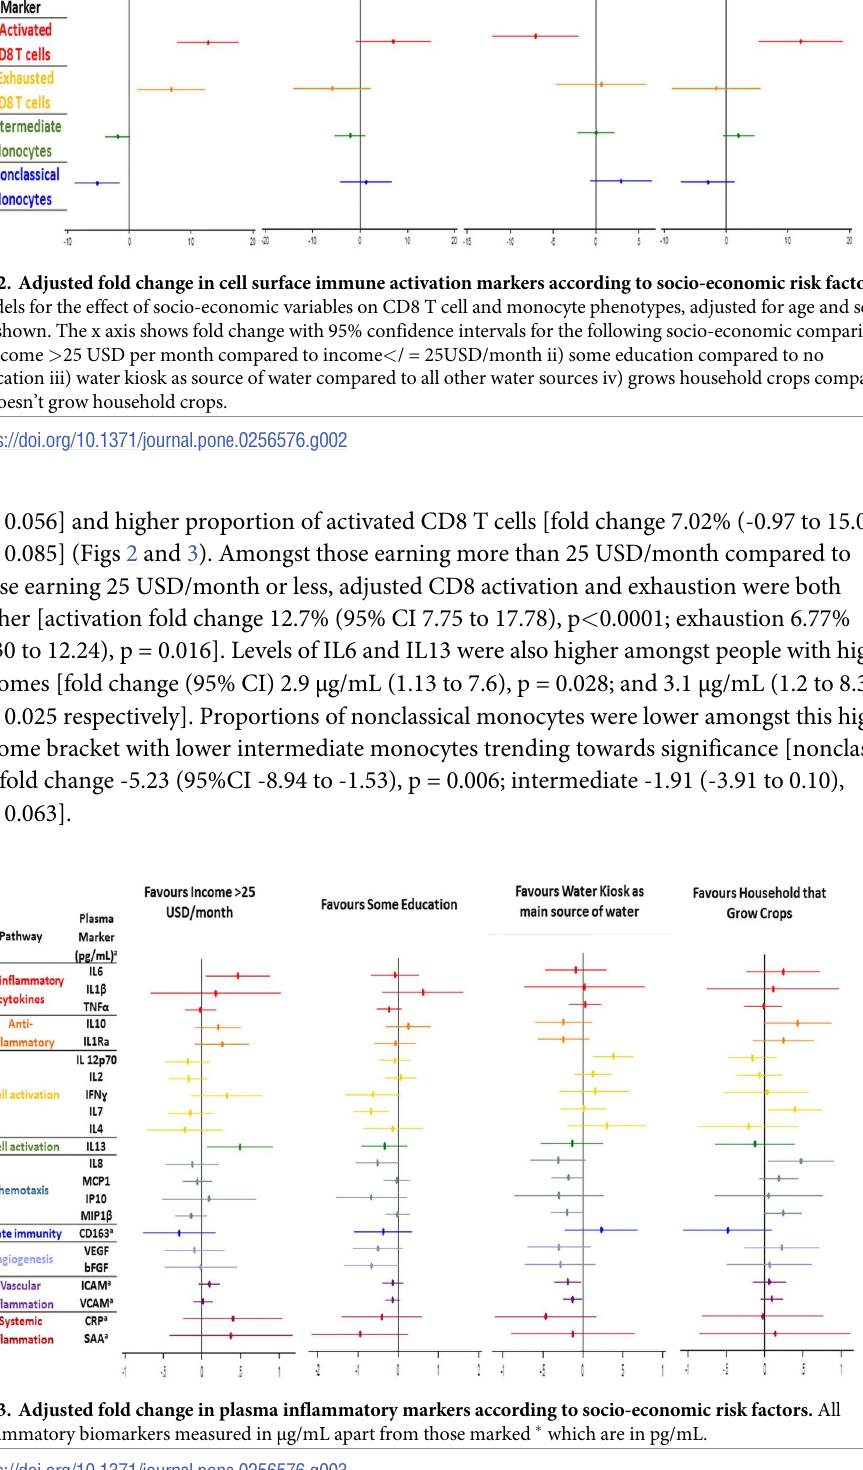
Fig 3. Adjusted fold change in plasma inflammatory markers according to socio-economic risk factors. All inflammatory biomarkers measured in μ g/mL apart from those marked � which are in pg/mL.